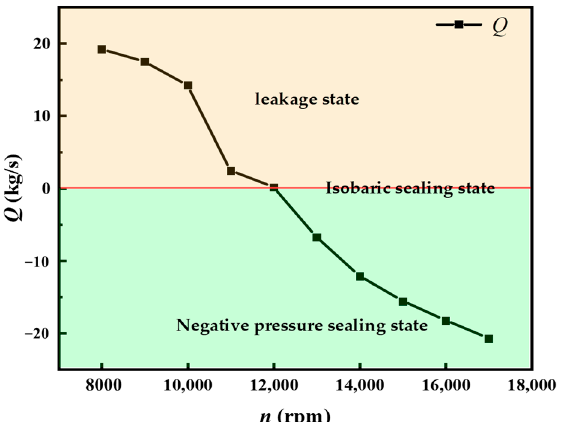
Figure 14. The changes in flow rate of the first-stage liquid-sealing impeller at different rotating speeds.